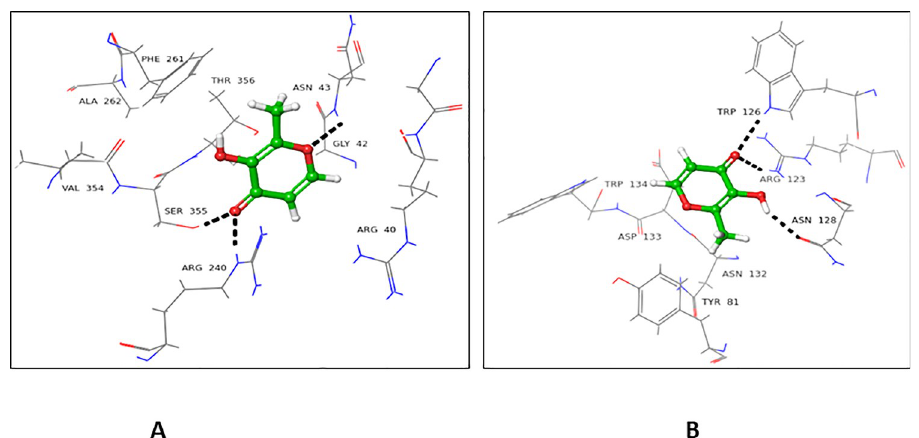
Fig 8. Interactions of compound 4 with (A) donor and ( B ) acceptor active site. 3D Ligand interactions diagram; black dashed lines represent hydrogen bonds.